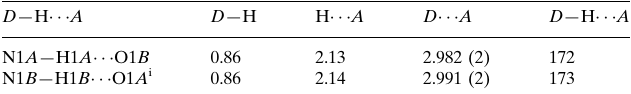
Hydrogen-bond geometry (A˚ , (cid:2)